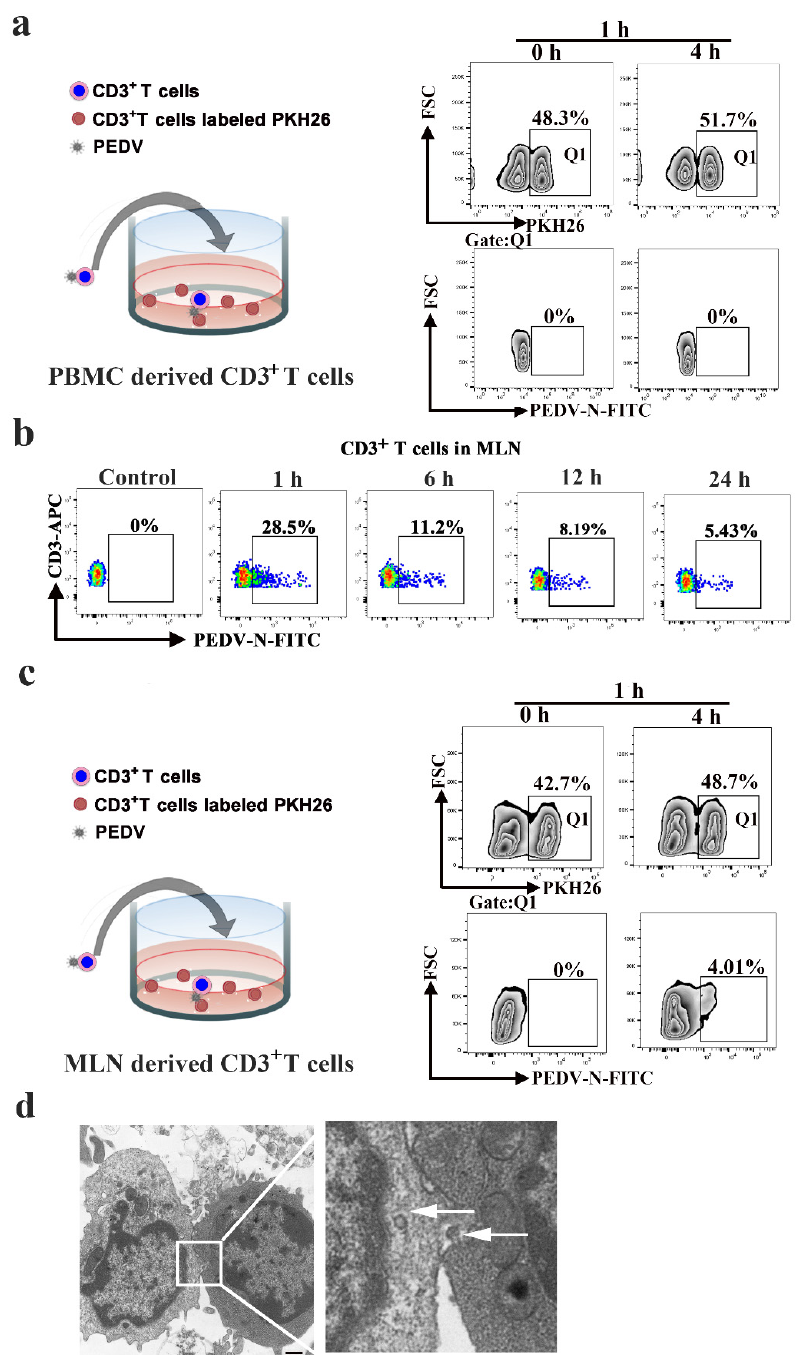
Figure 6. PEDV cell-to-cell transfer in CD3 + T cells of the lymph node. CD3 + T cells from PBMC ( a ) or the MLN ( c ) were infected with PEDV. These cells were then used as donors in the flow cytometry-based assay of viral transfer. Infected cells were co-cultivated with the indicated target PKH26 CD3 + T cells from PBMC or the MLN at a 1:1 ratio at the indicated time points. ( b ), CD3 + T cells from MLN were infected with PEDV at different times. The viral load values were detected using FACS. ( d ) The structures of lymphocyte-to-lymphocyte contacts were observed using transmission electron microscopy. In addition, we found complete virions at the site of cell-cell contact (arrowhead). The scale bar represents 1 µ m. MLN: mesenteric lymph node. Q1:PKH26+